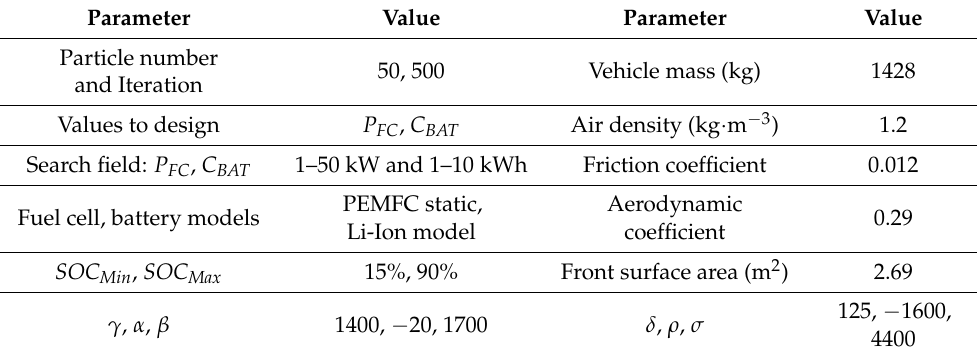
Table 1. Support tool parameters